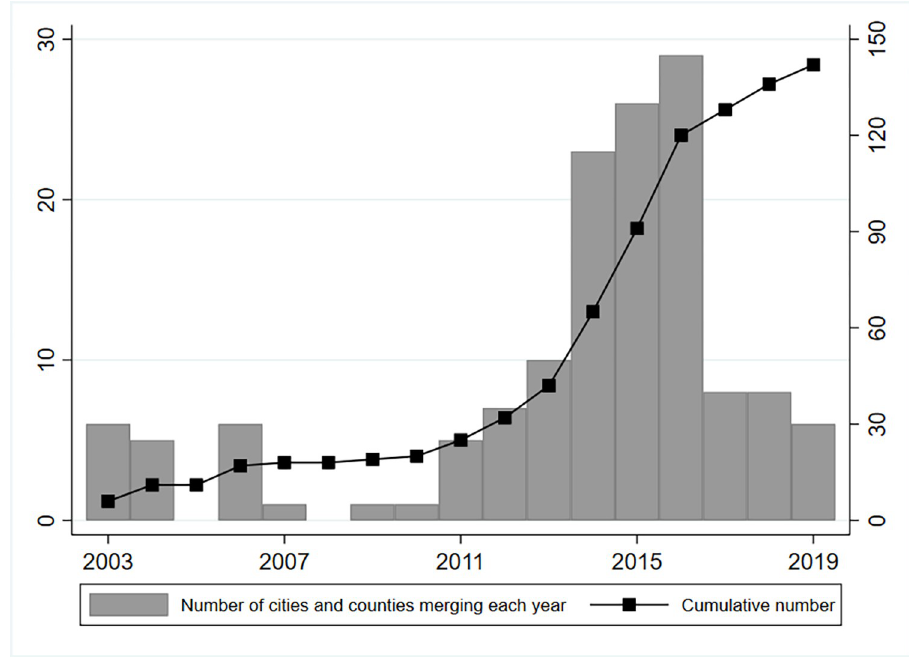
Fig 1. Number of cities with the policy of city-county mergers during